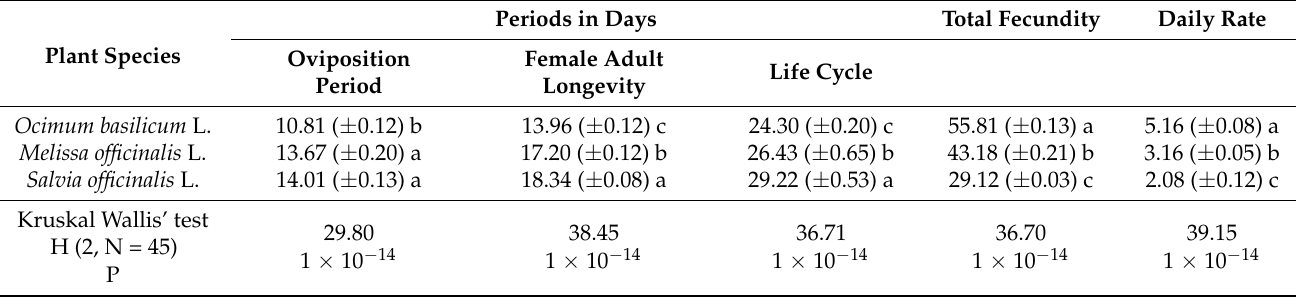
Table 2. Mean ( ± SE) biological parameters of Tetranychus urticae females reared on different species of medicinal plants. Periods in Days Total Fecundity Daily Rate Plant Species Oviposition Female Adult Life Cycle Period Longevity Ocimum basilicum L. Melissa officinalis L.